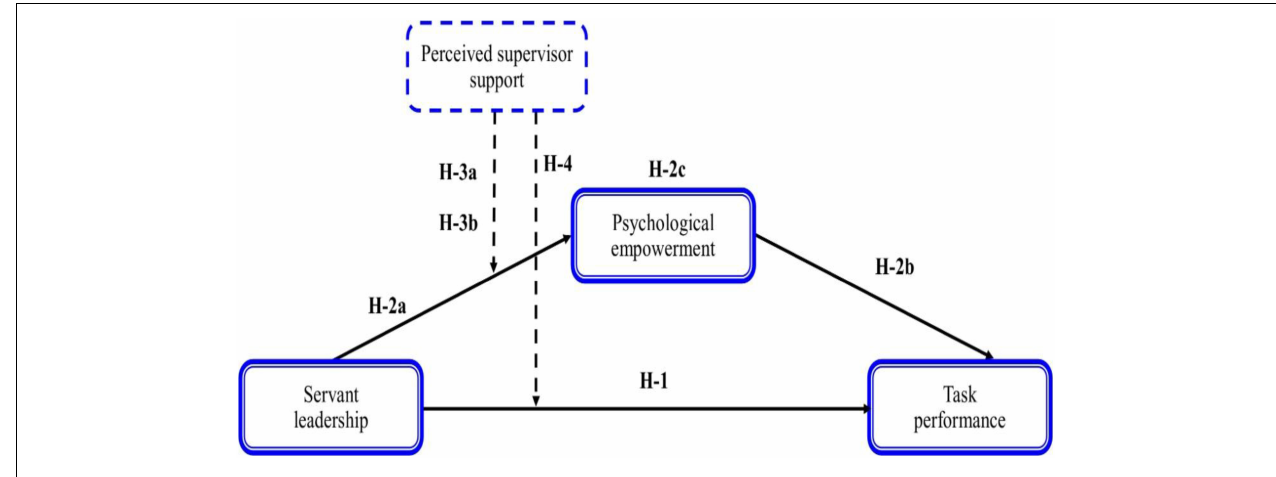
FIGURE 1 | Research model and